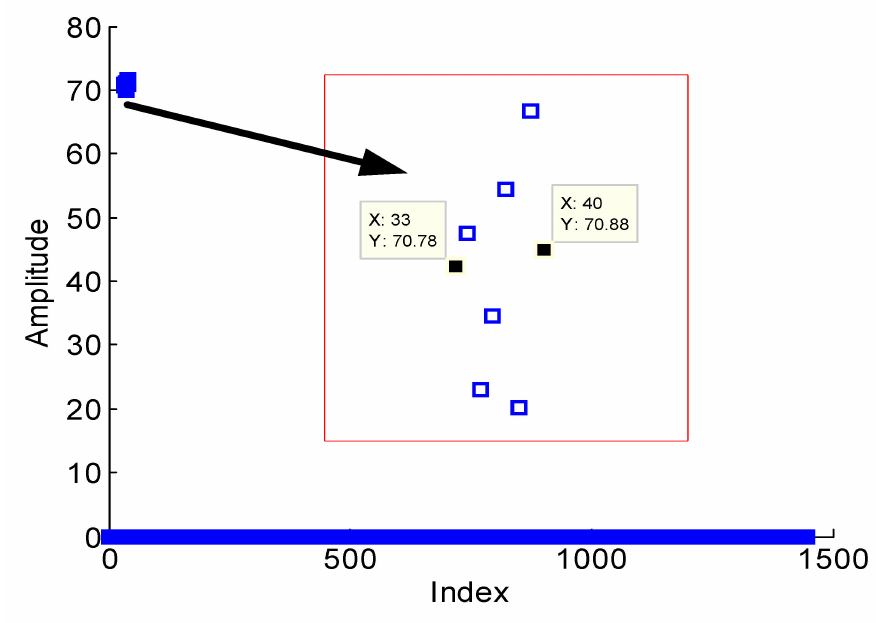
Figure 2. Support position estimation results based on BOMP sparse recovery. Example 2 of the verification of correctness of search range